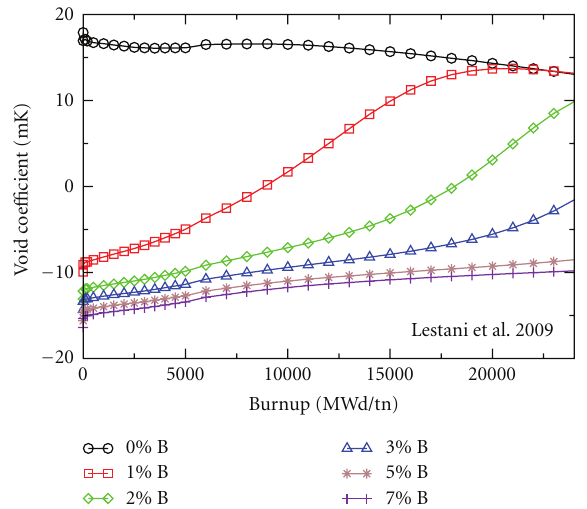
Figure 8: Evolution of coe ffi cient with burnup for di ff erent